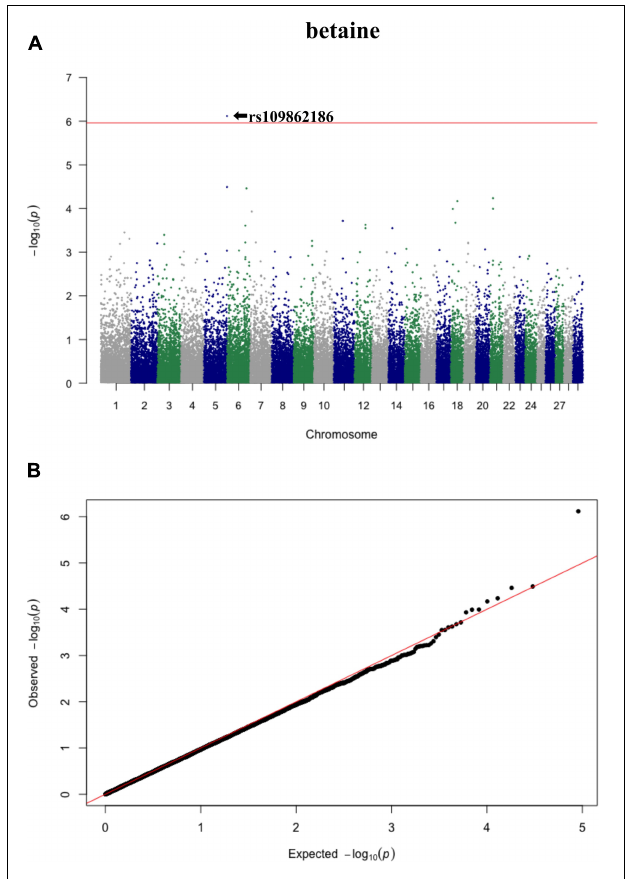
FIGURE 3 | Manhattan plot (A) and QQ plot (B) for L -alanine, significant SNPs were determined by Bonferroni correction (red